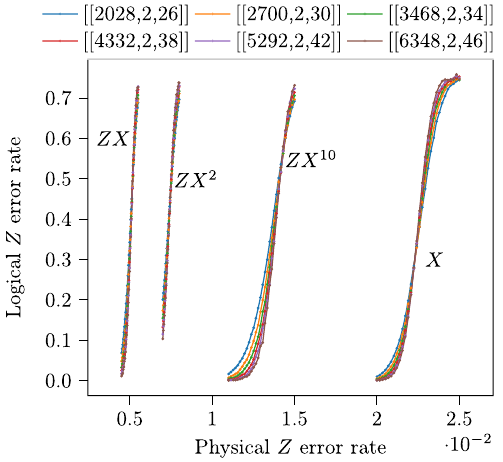
FIG. 14. Z thresholds for unbalanced schedules of the form ZX b , as well as an X schedule, which gives an upper bound on the Z threshold achievable using unbalanced schedules.